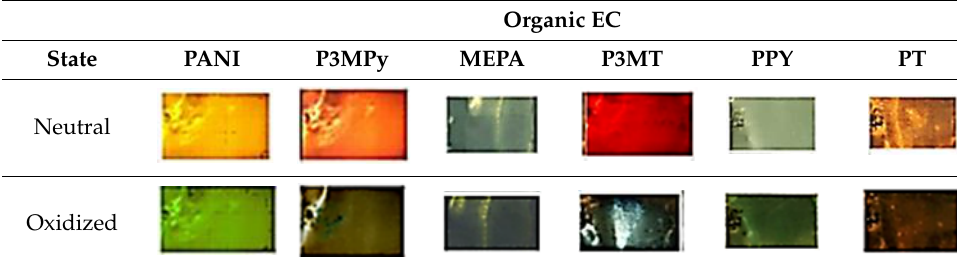
Table 4. Conductive polymers obtained by the oxidation of monomeric aromatic compounds (neutral and oxidized states).